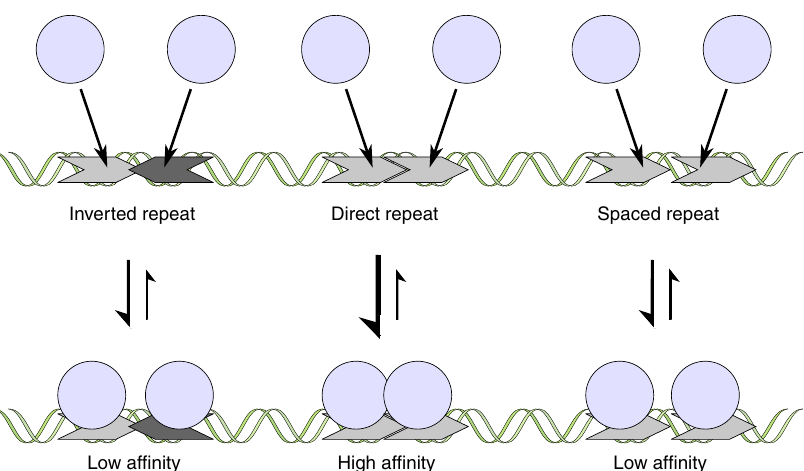
Fig. 7 DNA-binding behavior of WUS-HD. Schematic representation summarizing the complex DNA-binding behavior of the At WUS-HD to tandemly arranged recognition motifs. The WUS-HD (light blue) binds to speci fi c DNA recognition sequences (gray), which can differ in their orientation and arrangement relative to each other. In the case of direct repeat sequences DNA-binding of the HD facilitates WUS-homodimerization via speci fi c protein- protein interactions, leading to a cooperative gain in binding af fi nity. In contrast, inverted tandem repeats or direct repeats separated by a spacer do not allow protein – protein interactions to begin with and therefore are recognized with much lower af fi